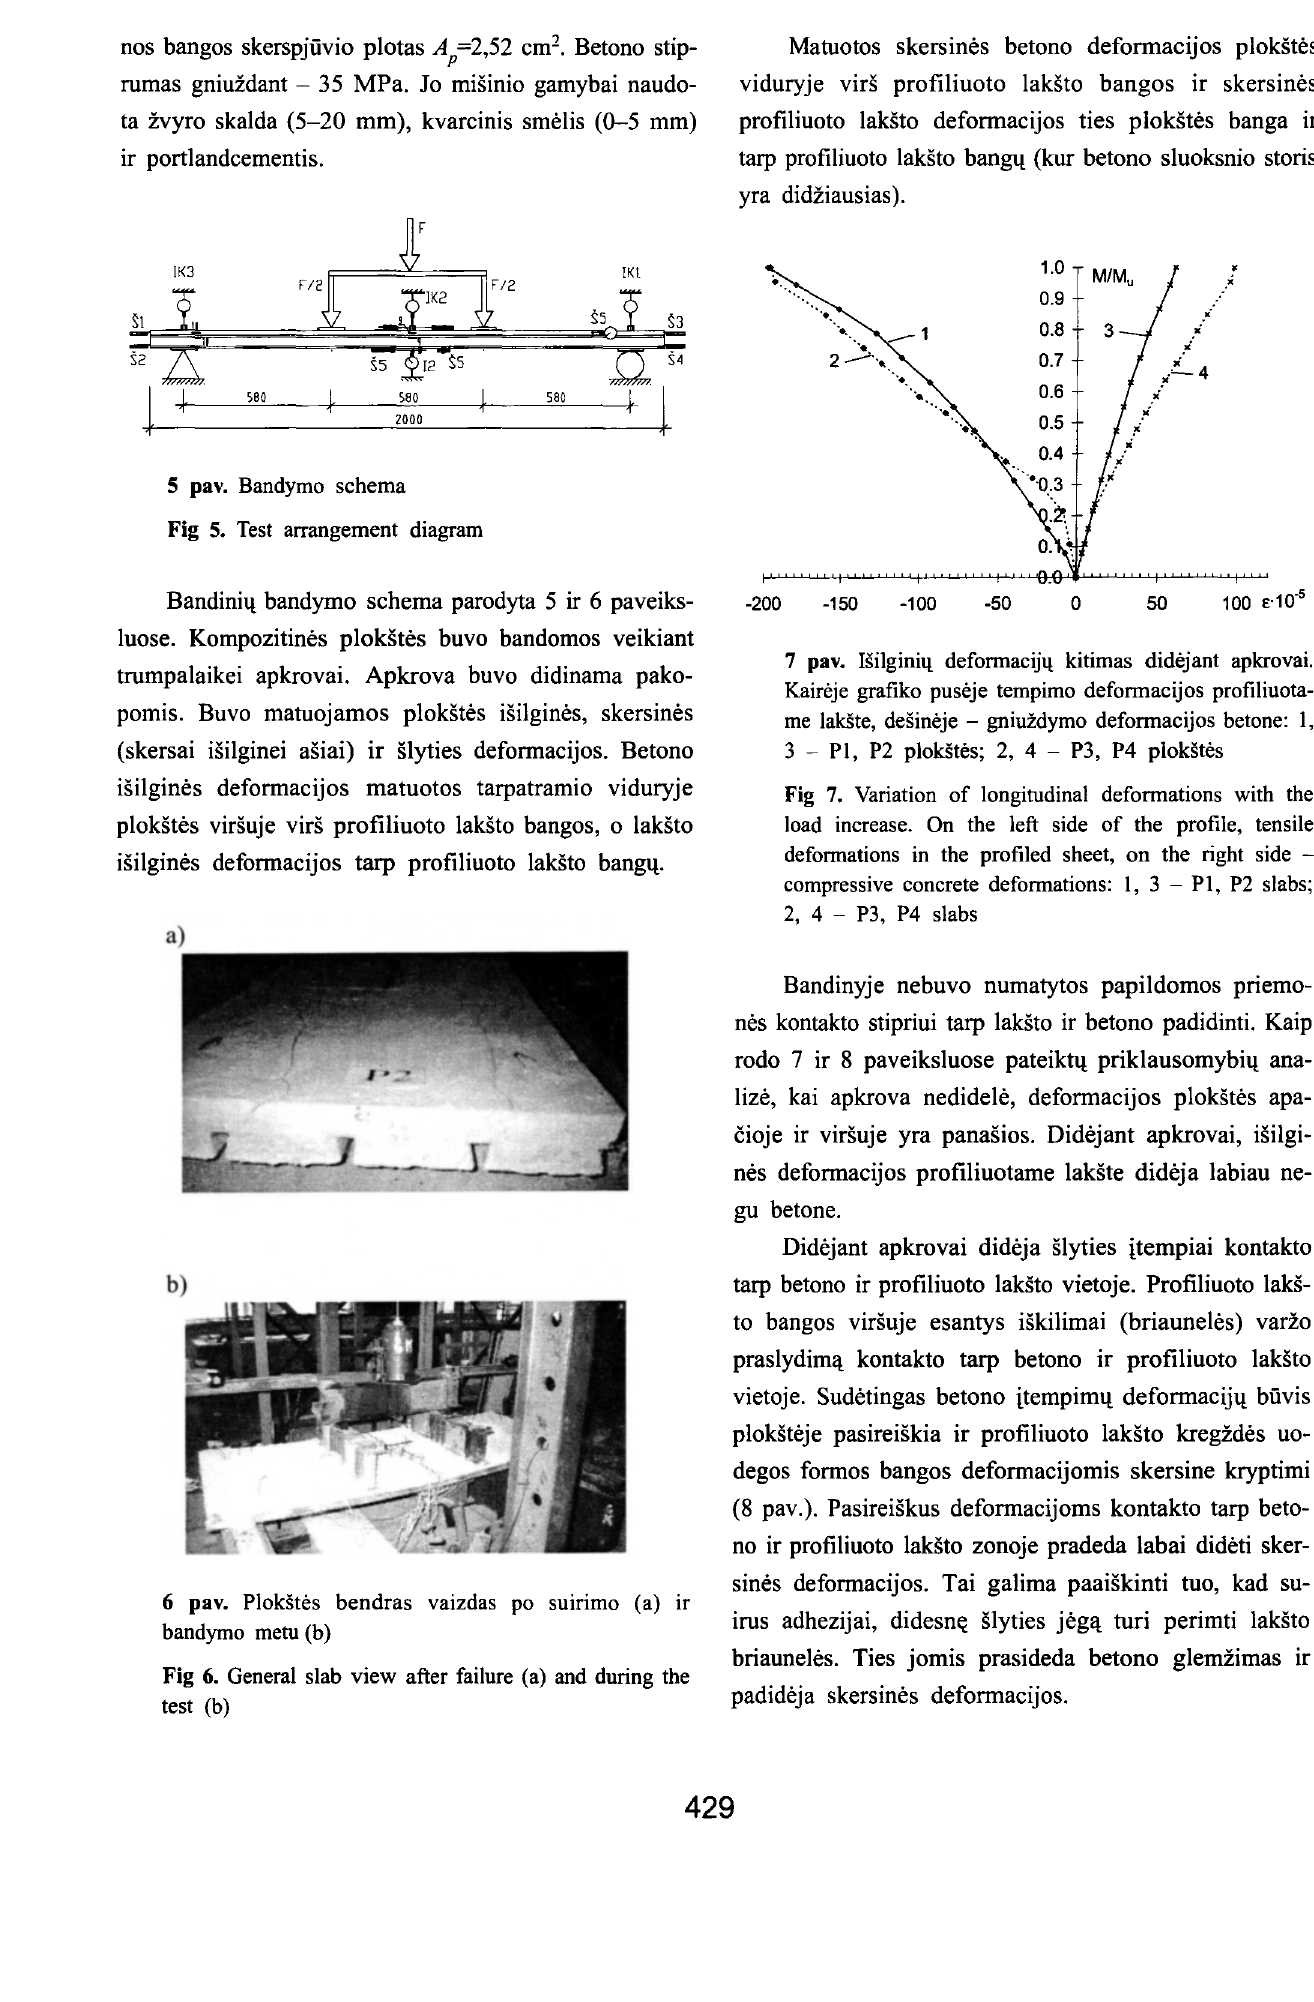
nos bangos skerspjiivio plotas AP =2,52 cm 2 • Betono stip